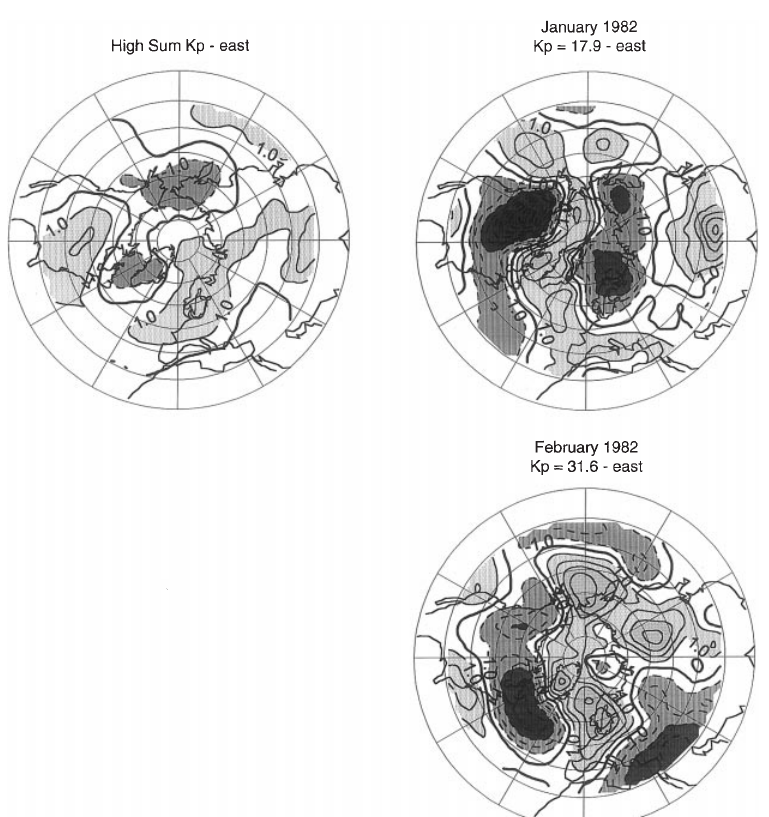
Fig. 5. Distribution of pressure deviations in indi- vidual months of winter period 1982 in comparison with composite map of pressure deviations at high sum Kp, QBO-east. The intervals between contours are 2 mb